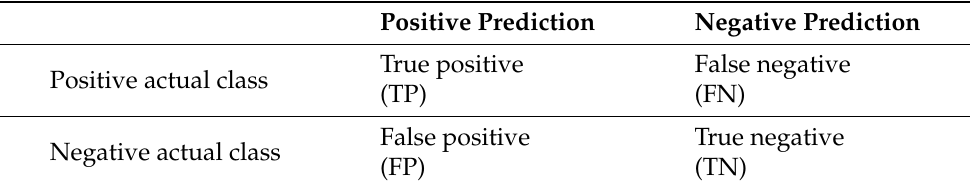
Table 3. Confusion matrix.